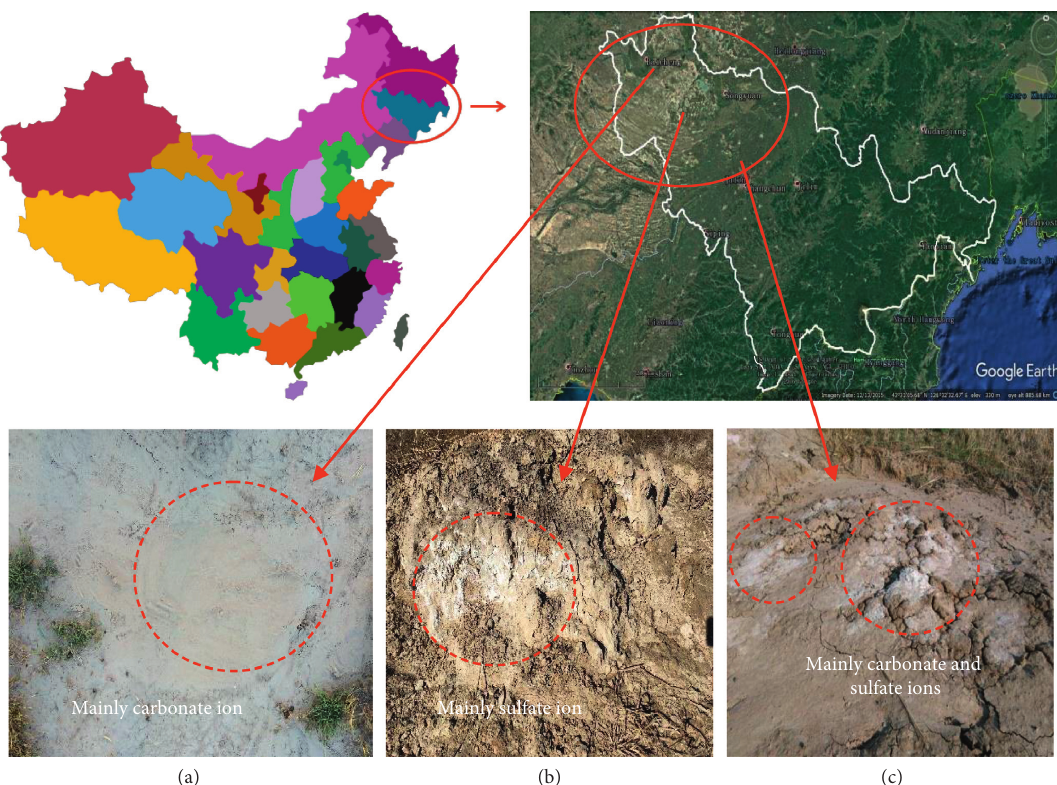
Figure 1: (a) Research environment (saline soil) in Zhenlai, (b) Da’an, and (c)